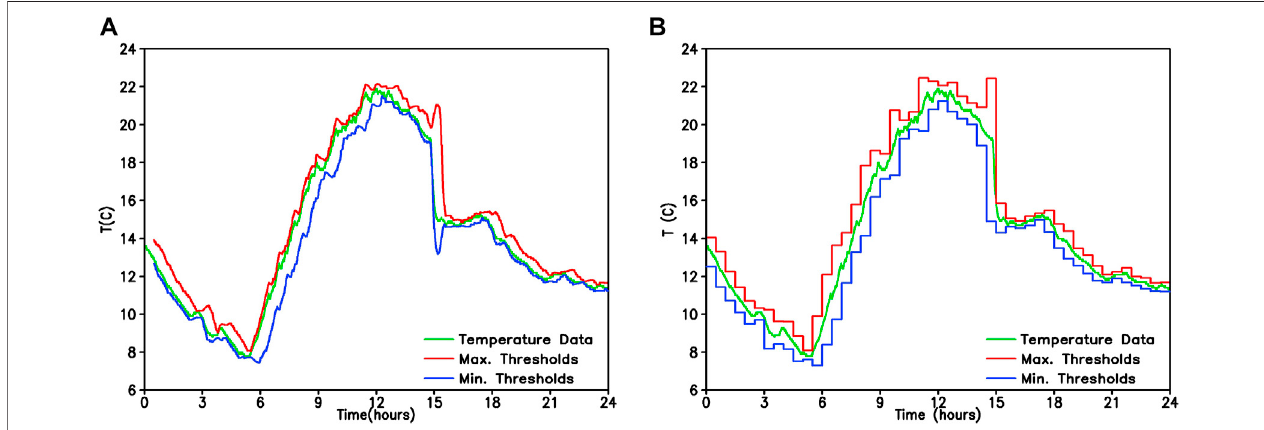
FIGURE 1 | The fast threshold test results for raw temperature data at SA station on 29 April 2016 (Unit: ° C). (A) Scheme 7; and (B) scheme 11 (The 0.5 Hz temperature data (green line); the upper limits per minute (the maximum thresholds, red line); and the lower limits per minute (the minimum thresholds, blue line)).